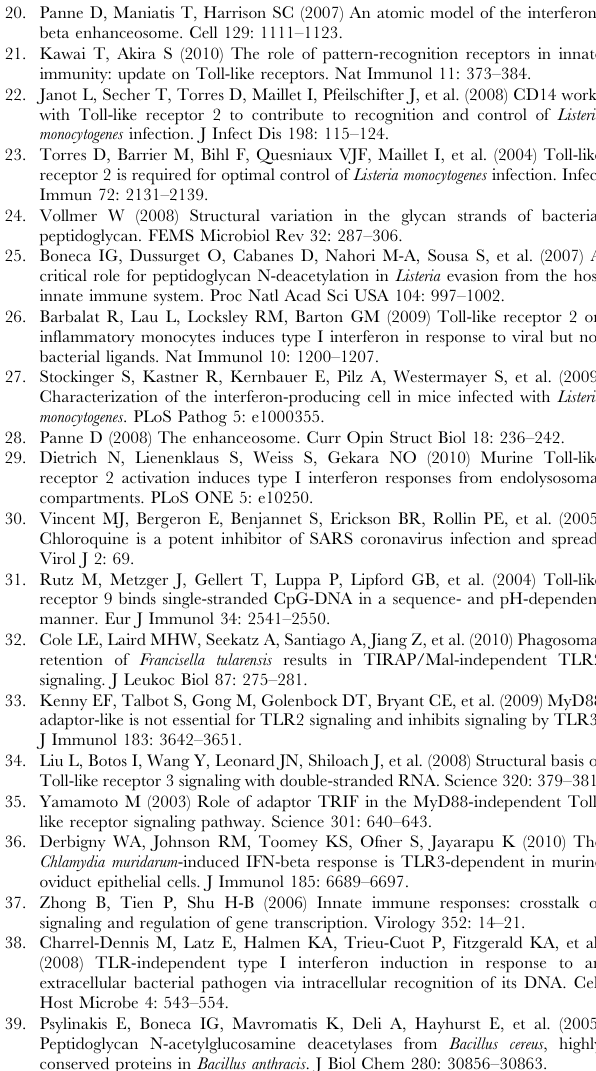
Figure S2 TLR2 is required for optimal activation of NF- k B. (A) PEM from WT C57BL/6J mice were infected with EGDe. Cells were lysed 0, 0.5, 1, 1.5, 2, 2.5, or 3 h post-infection. Activation of NF- k B was measured by determination of I k B degradation relative to tubulin following immunodetection. (B) PEM from tlr2 2 / 2 mice were infected with EGDe. Cells were lysed 0, 0.5, 1, 1.5, 2, 2.5, or 3 h post-infection. Activation of NF- k B was measured by determination of I k B degradation relative to tubulin following